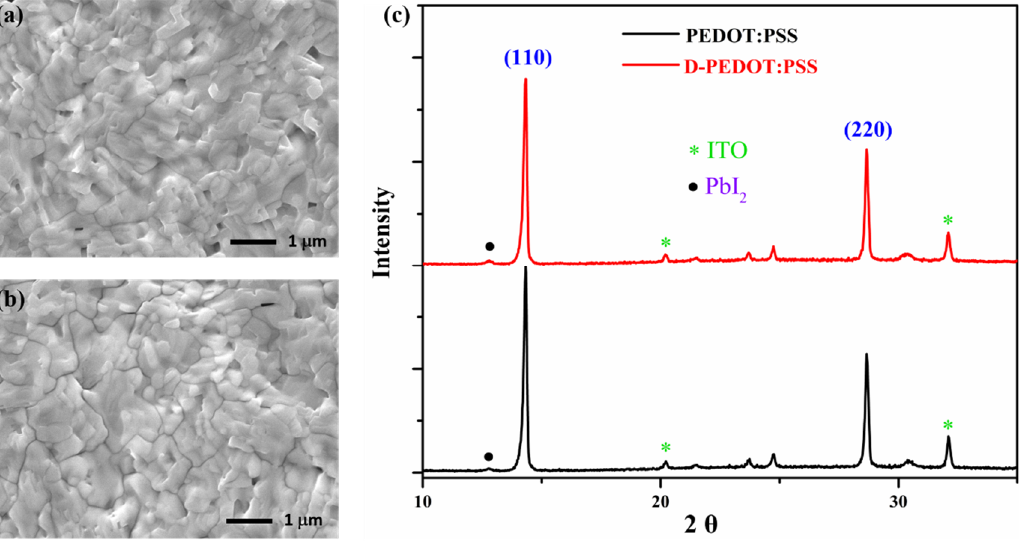
Figure 3. SEM images of perovskite films on ( a ) PEDOT:PSS and ( b ) D-PEDOT:PSS, respectively; ( c ) XRD patterns.